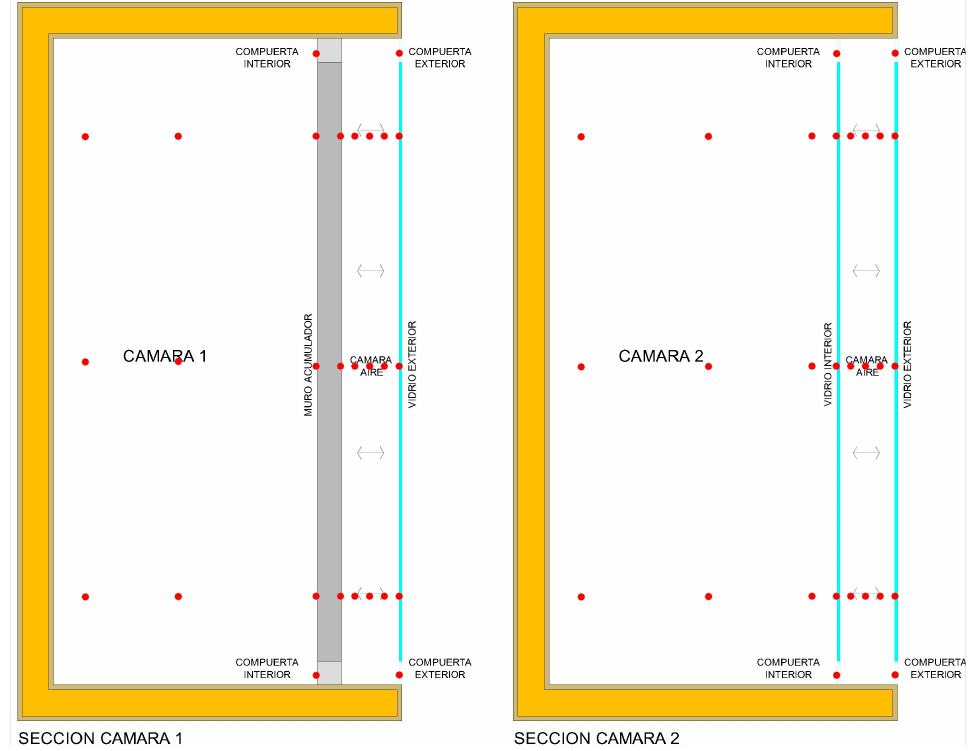
Figure 5. Sensor system. The SECCIÓN CAMARA (section or the room 1, on the left and 2, on the right) shows the section of the two rooms with the location of the sensor systems, i.e., red dots.